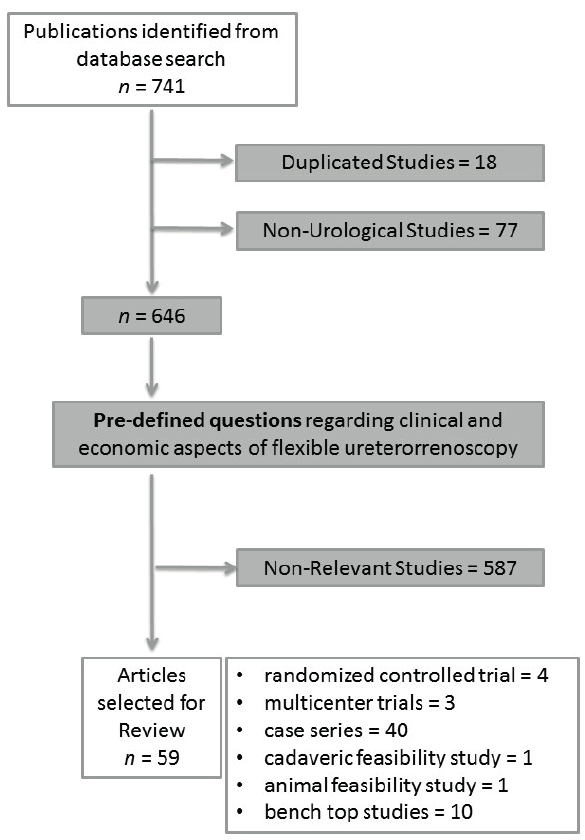
Figure 1 - Flow diagram of evidence acquisition in a systematic review on single-use and reusable flexible ureteroscopy.